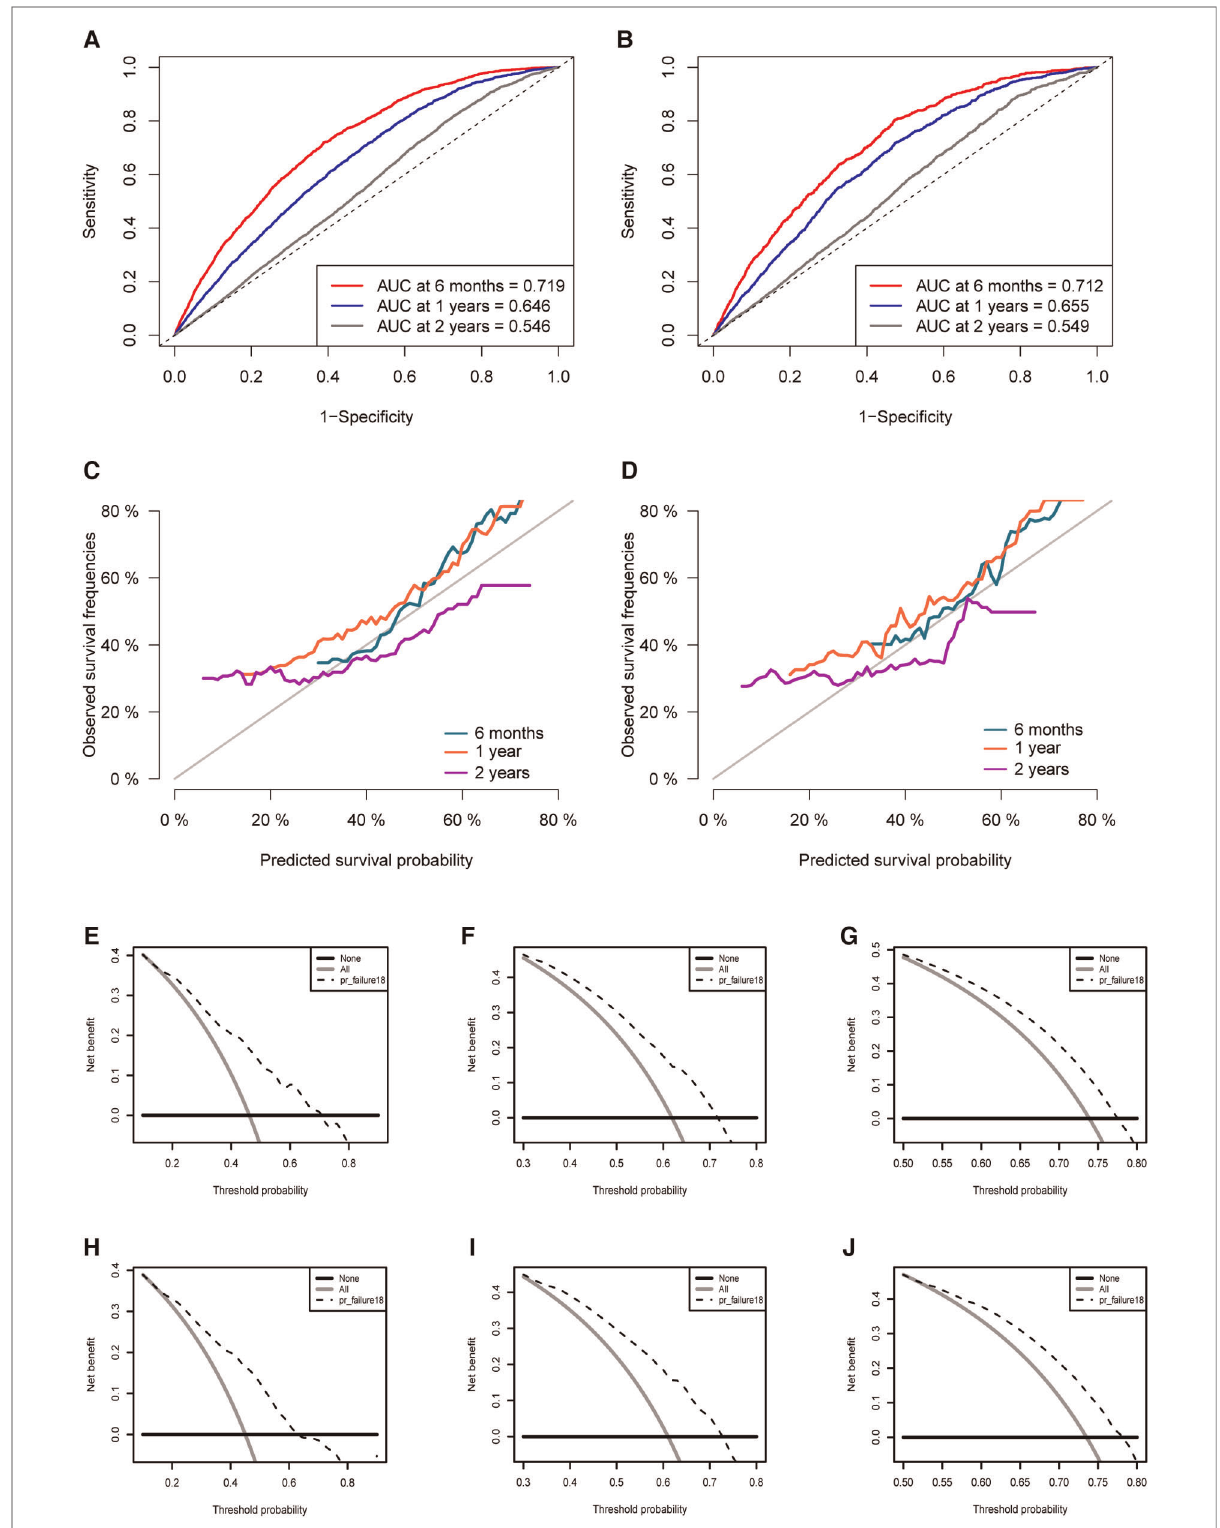
FIGURE 7 Area under the receiver operating characteristic curve for the training set ( A ) and validation set ( B ). Calibration curves in the training set ( C ) and validation set ( D ). Decision curves for half a year ( E ), 1 year ( F ), 2 years ( G ) in the training set. Decision curves for half a year ( H ), 1 year ( I ), 2 years ( J ) in the validation